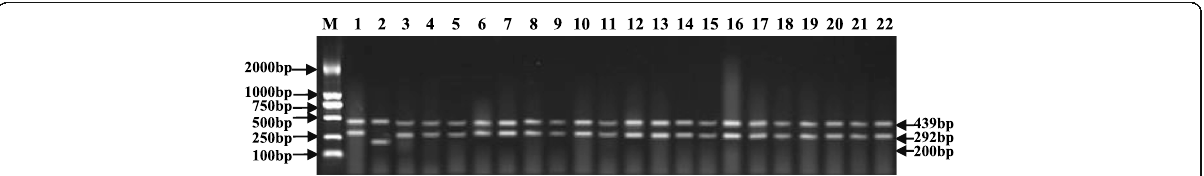
Fig. 2 Detection of the Wx mp gene in 64 semi waxy